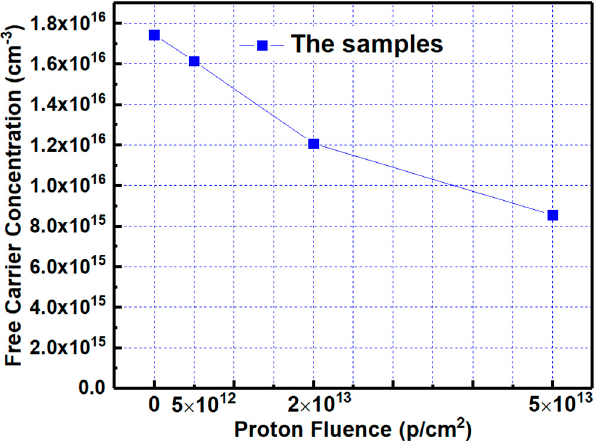
Figure 5. The free carrier concentration of the epilayer versus proton fluence.